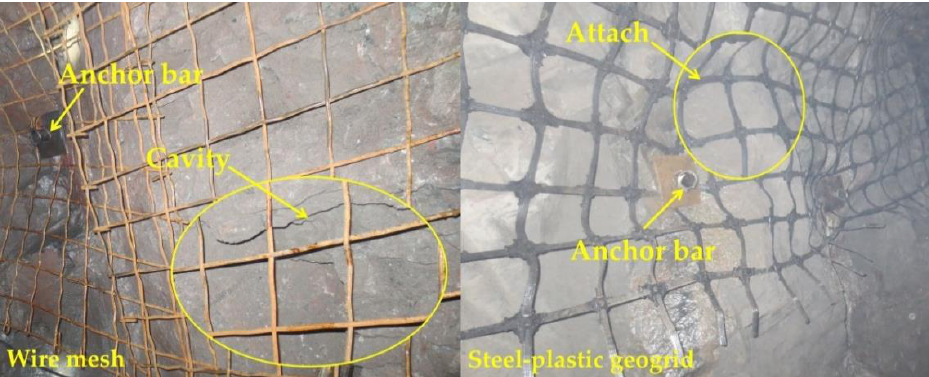
Figure 17. Comparison of the degree of fit of the mesh to the surrounding rock.